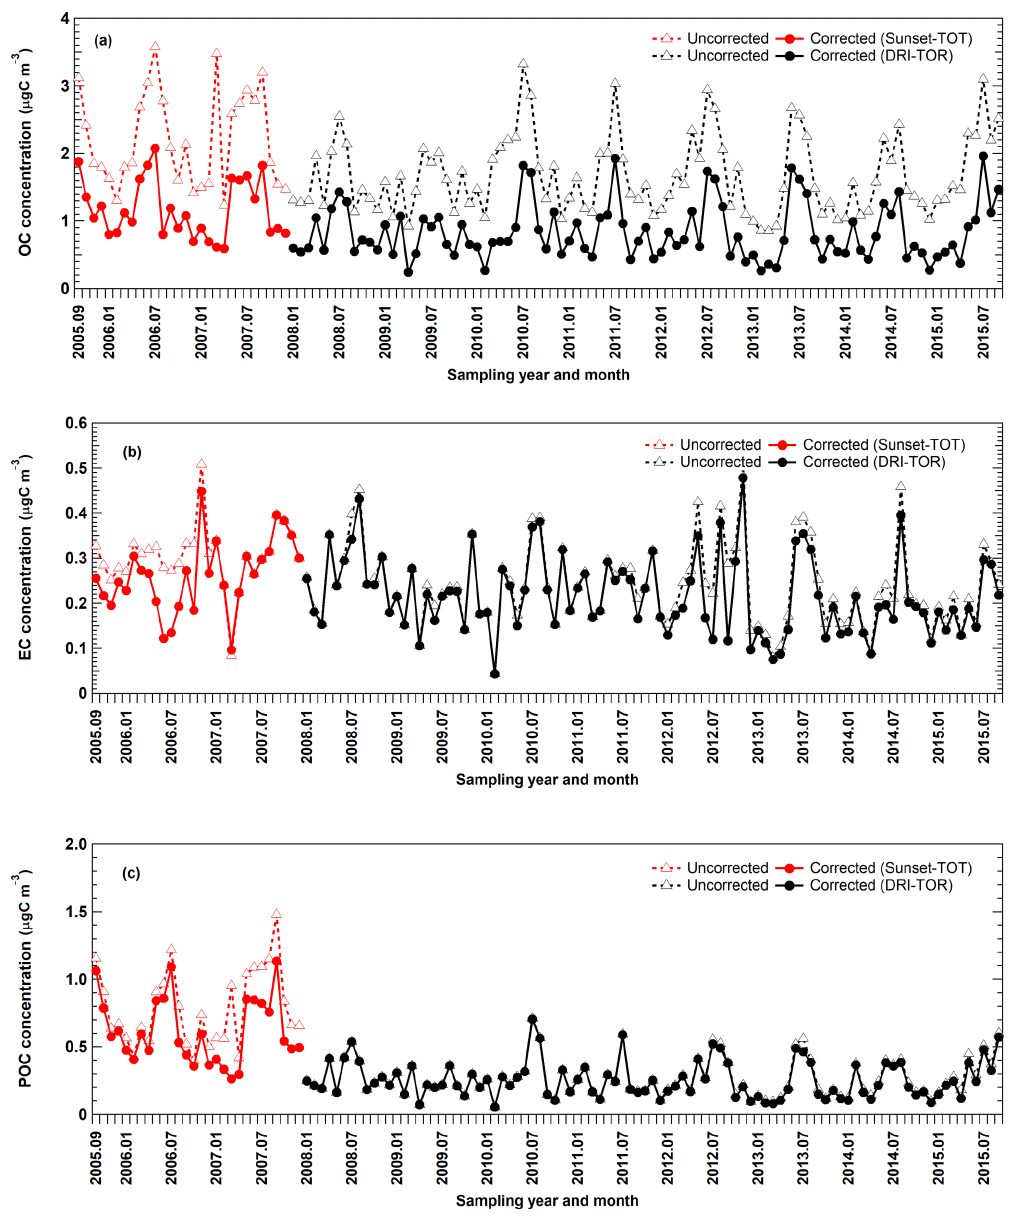
Figure 4. Monthly averaged CAPMoN (a) OC, (b) EC, and (c) POC mass concentration time series with and without vapour adsorption correction. Note that the y axes in (a) , (b) , and (c) are on a different scale.